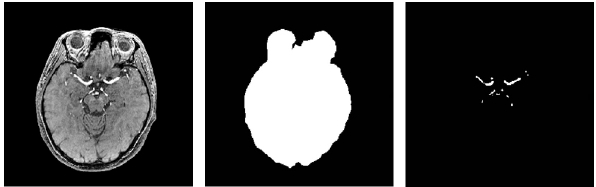
Fig. 10 Left: an original MRA image slice. Middle: the corre- sponding ROI mask for skull-stripping generated by BET2. Right: the corresponding ROI surface mask generated by our surface model to provide the same input region for the DeepMedic model.